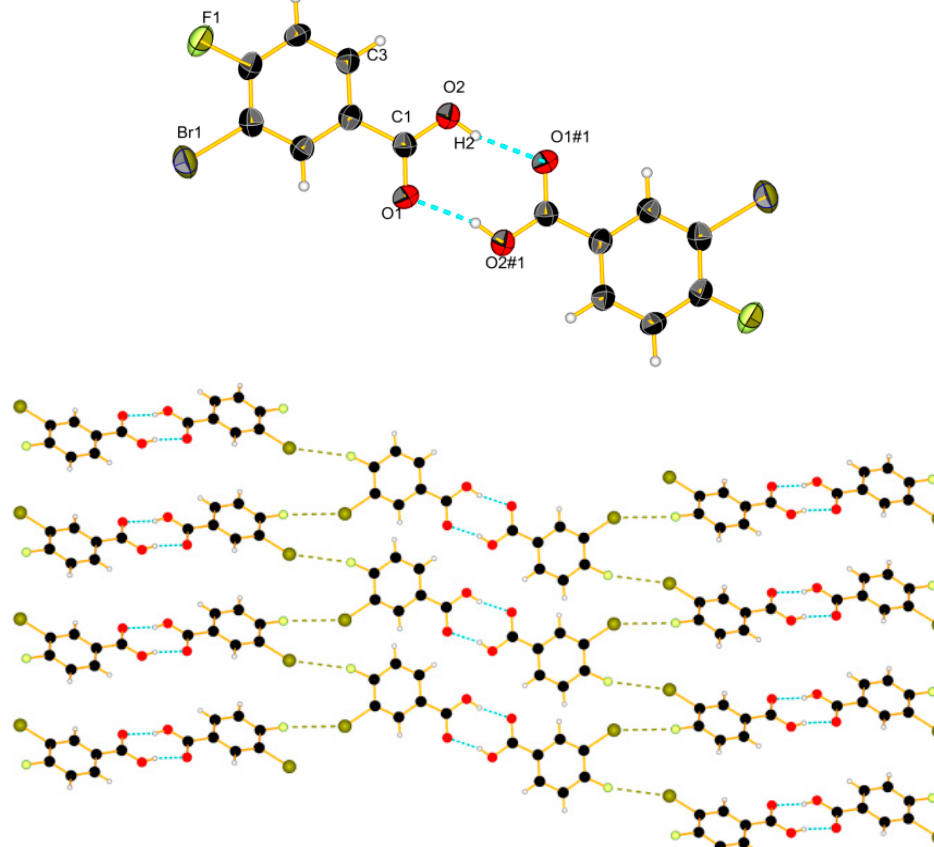
Figure 1. View of the molecular structure of 2 : ( top ) with hydrogen bonds in blue dashed lines, 50% probability (#1 = − x , 2 − y , − z ); ( bottom ) packing with short contacts between halogen atoms in khaki dashes.